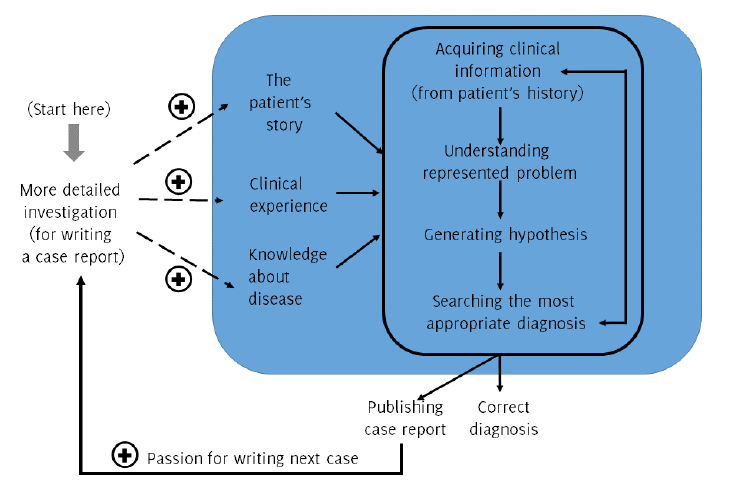
Figure 1. Proposed Modification of Bowen’s Model of Key Elements of Clinical Diagnostic Reasoning 5